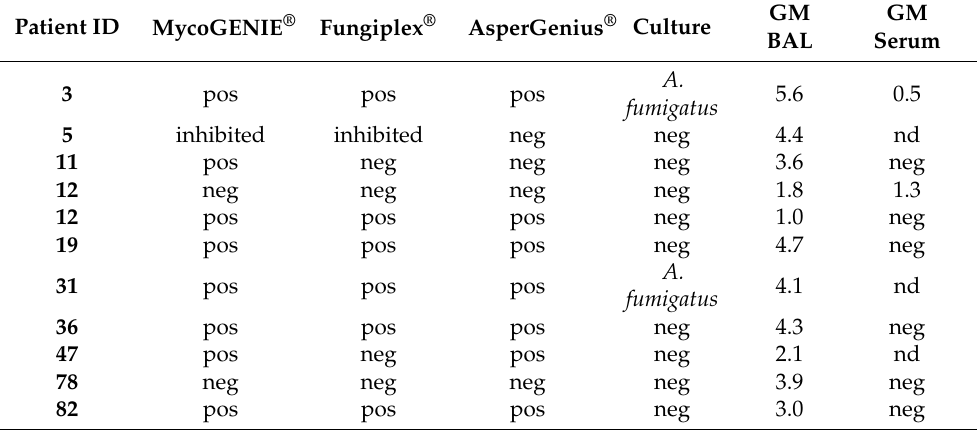
Table 2. Characteristics of samples from patients categorised in the probable IPA group.